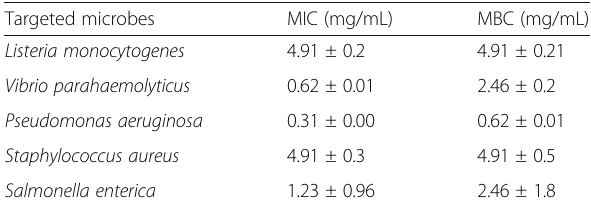
Table 2 Minimum inhibitory concentration (MIC) and minimum bacterial concentration of COS-L from squid